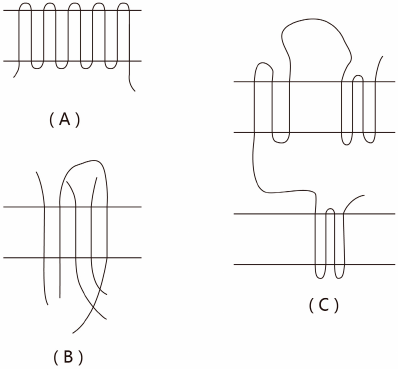
Figure 2. Schematic diagram of molecular trajectory in various models: ( A ) Adjacent re-entry model. ( B ) Switchboard model. ( C ) Intramolecular nucleation model.